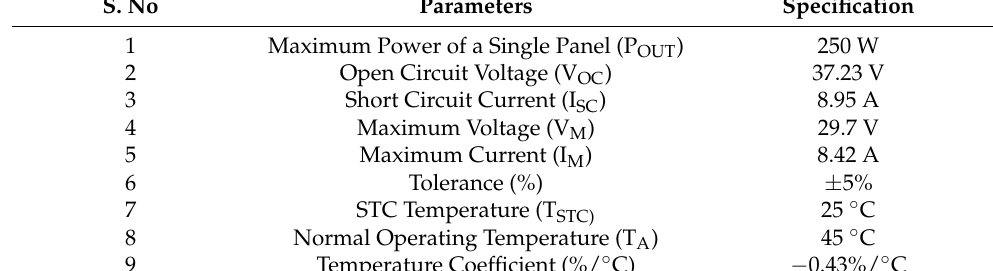
Table 1. Specifications of PV panel. Figure 3. Flow chart of the proposed algorithm.